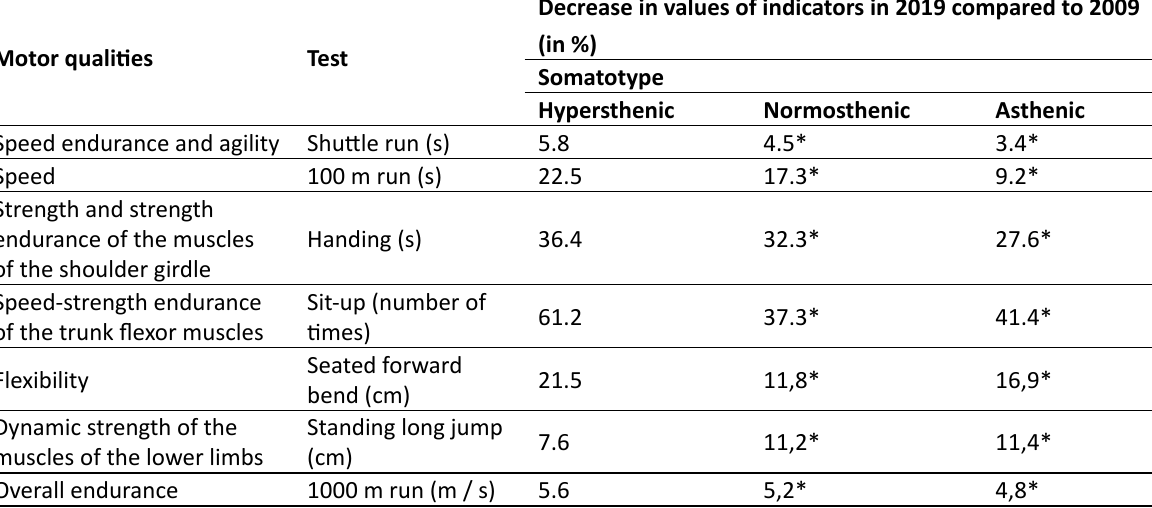
Motor qualities